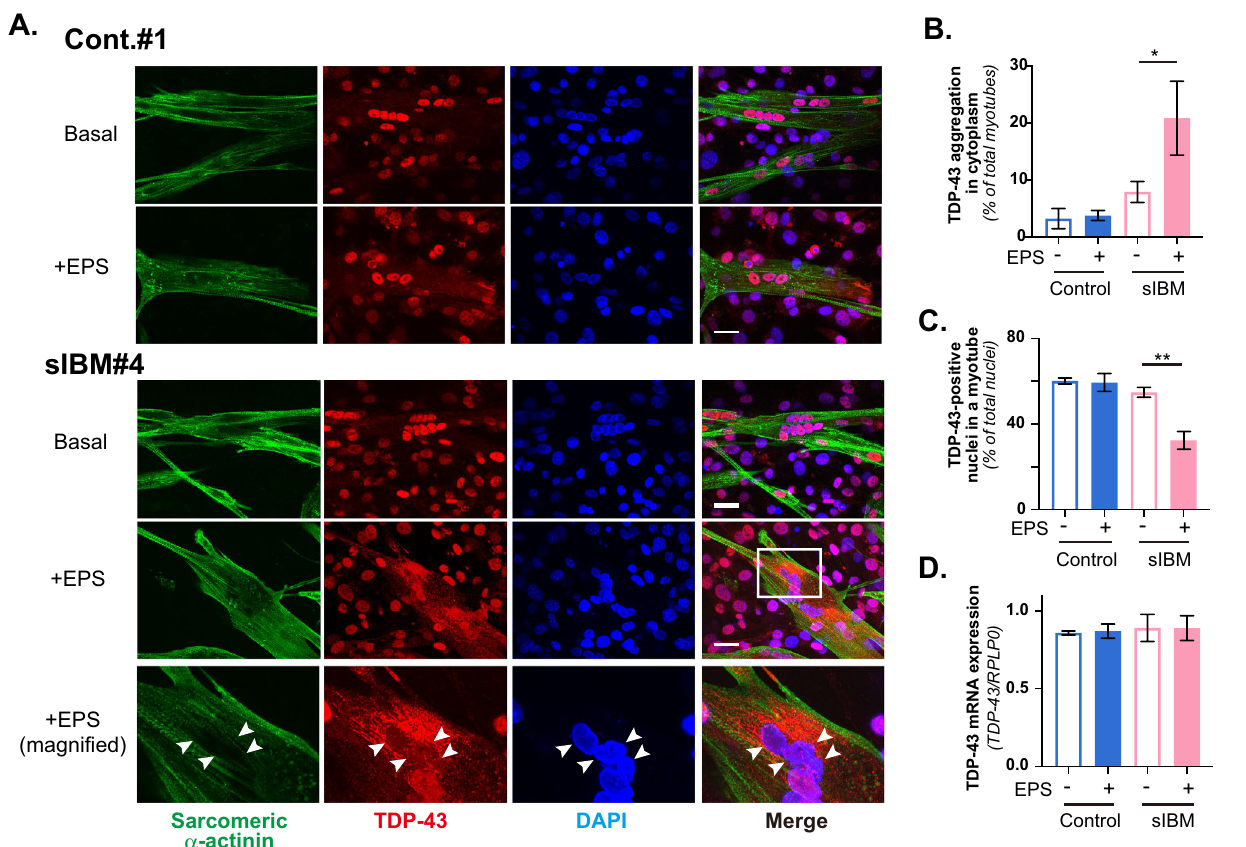
Figure 4. Subcellular localization of TDP-43 in sIBM myotubes of feeder-supported in vitro exercise model. ( A ) Six human myotube preparations originating from 3 healthy control subjects (Cont. #1–#3) and 3 sIBM patients (sIBM#4–#6) were subjected to immunofluorescent staining analysis. After 7–8 days of differentiation, the differentiated human myotubes on the feeder layers of mouse 3T3L1 fibroblasts were subjected to EPS treatments, fixed and then observed for subcellular localization of TDP-43 by using anti-TDP-43 and anti- sarcomeric-α-actinin antibodies, as described in the “Methods” section. DAPI was used for nuclear staining. Scale bar = 25 μm. Three independent experiments were performed, and one healthy control and one sIBM myotube are each presented as the representative images. Note that cytoplasmic TDP-43 accumulation is observed in sIBM myotubes after EPS-evoked contraction ( lower two row panels ). A magnified image of the white box (sIBM myotubes + EPS) is also presented ( the bottom panels ). Scale bar = 25 μm. ( B,C ) For quantification, 5 different fields in the images (of which each field usually contained 6–12 myotubes) were taken and the numbers of myotubes possessing intracellular TDP-43 accumulations as well as the numbers of TDP-43-positive nuclei in the myotube were counted, as described in the “Methods” section. Three independent experiments using the same cell stock samples were performed. Quantification of the ratio of myotubes displaying cytoplasmic TDP-43 accumulations ( B ) and the ratio of TDP-43-positive nuclei in the myotube ( C ) were determined from more than 60 myotubes in three independent experiments. The data are shown as the mean ± SE (healthy control and sIBM myotubes, n = 3 each). The statistical significance of differences was analyzed using ANOVA with Dunnett’s multiple comparison test; * p < 0.05 and ** p < 0.01 indicating the effects of EPS treatment. ( D ) Total RNA was extracted and mRNAs for human TDP-43 and RPLP0 were evaluated by real-time PCR analysis. Data were normalized using human RPLP0 transcripts. This graph shows the results of three independent experiments performed using the same cell stock samples (healthy control and sIBM myotubes, n = 3